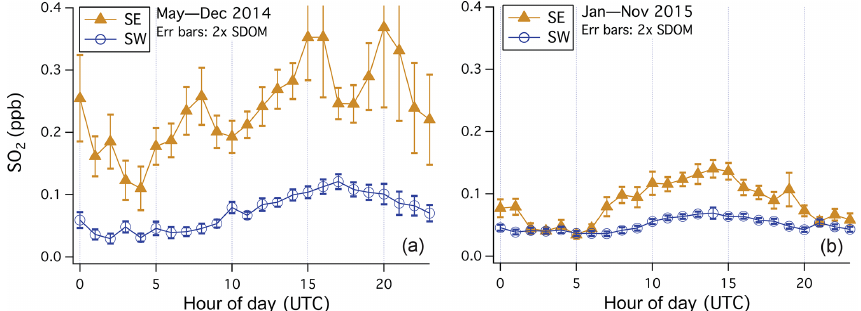
Figure 5. Average diel cycles of SO 2 mixing ratio, separated into the southeastern and southwestern wind sectors for 2014 (a) and 2015 (b) . SO 2 in the southwestern sector showed diel variability that is largely consistent with DMS oxidation. SO 2 in the southeastern sector was significantly lower and less variable in 2015 than in